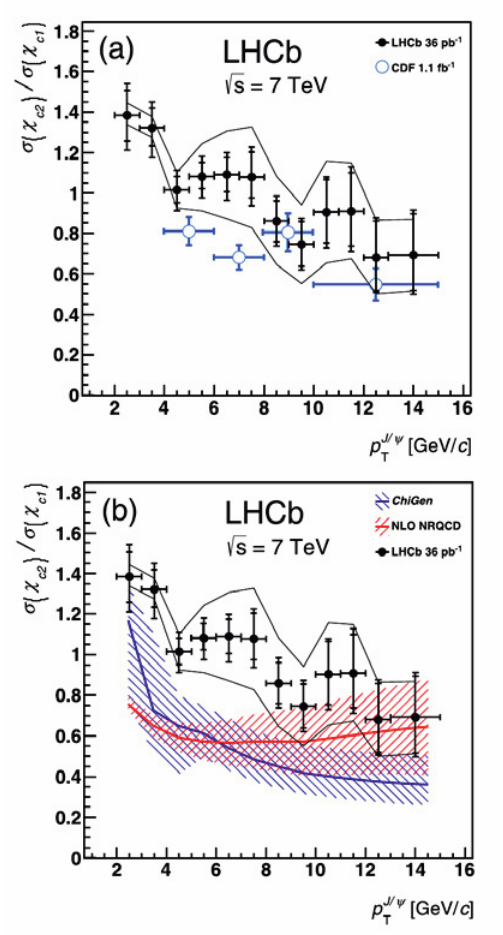
Figure 20. Ratio σ ( χ 2 c ) /σ ( χ c 1 ) in bins of 2 < p J /ψ T < 15GeV / c . The LHCb results, in the rapidity range 2 . 0 < y J /ψ < 4 . 5 and assuming the production of unpolarised χ c mesons, are shown with solid black circles and the internal error bars correspond to the statistical error; the external error bars include the contribution from the systematic uncertainties (apart from the polarisation). The lines surrounding the data points show the maximum e ff ect of the unknown χ c polarisations on the result. The upper and lower limits correspond to the spin states as described in the text. The CDF data points are superimposed in (a) with open blue circles [32]. The two hatched bands in (b) correspond to the ChiGen Monte Carlo generator [34] and NLO NRQCD [33] predictions.